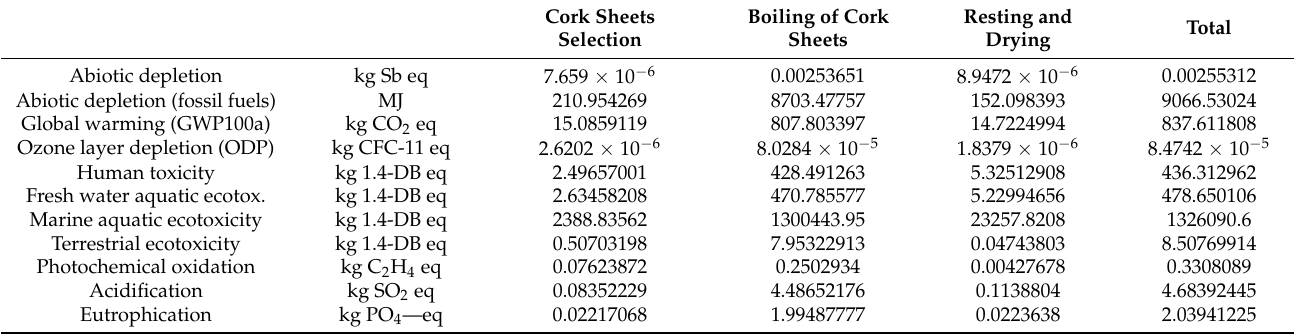
Table 7. Impact of stage 1 broken down by activities for the manufacturing process of 2-piece drilling-perforated stoppers, of 26mm in diameter and 44mm in